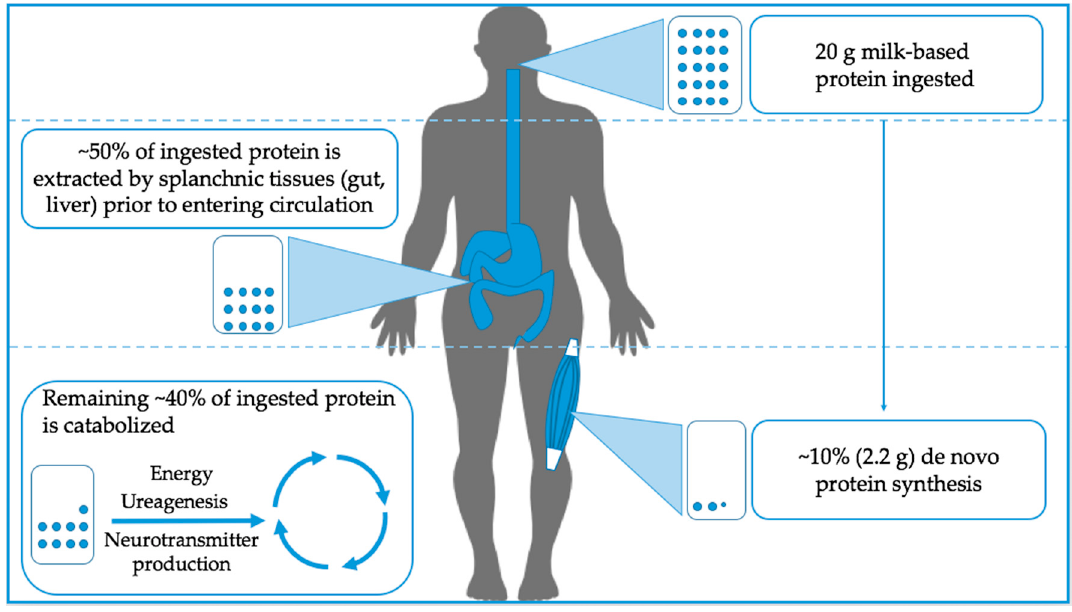
Figure 1. Simplified overview of whole body oral protein utilization at rest. Of the protein ingested, approximately 50% is extracted by splanchnic tissues before entering peripheral circulation. Interestingly, only ~10% of the ingested protein is utilized for skeletal muscle protein synthesis while the rest is catabolized.